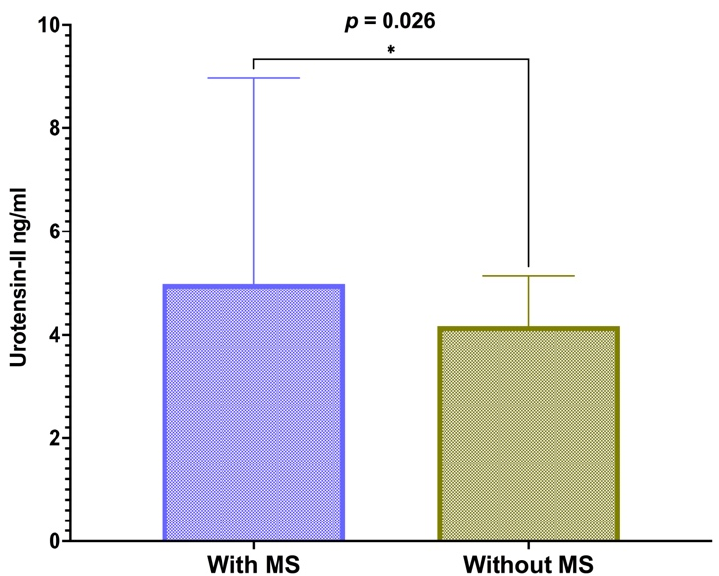
Figure 1. Levels of serum urotensin-II regarding the presence of the metabolic syndrome. * Signifi- cance level ( p ) was set to <0.05.